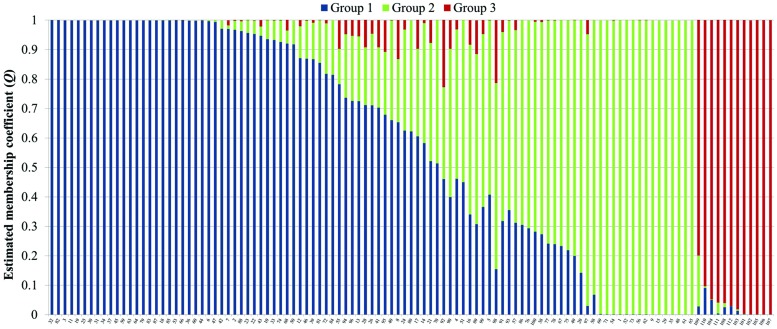
Bayesian analysis of population structure in the cauliflower diversity panel assigning the accessions to three subpopulations. Each genotype is represented by a vertical bar, which is partitioned into K colored segments that represent the individual’s estimated membership coefficient (Q) to the K clusters (STRUCTURE 2.3.4).